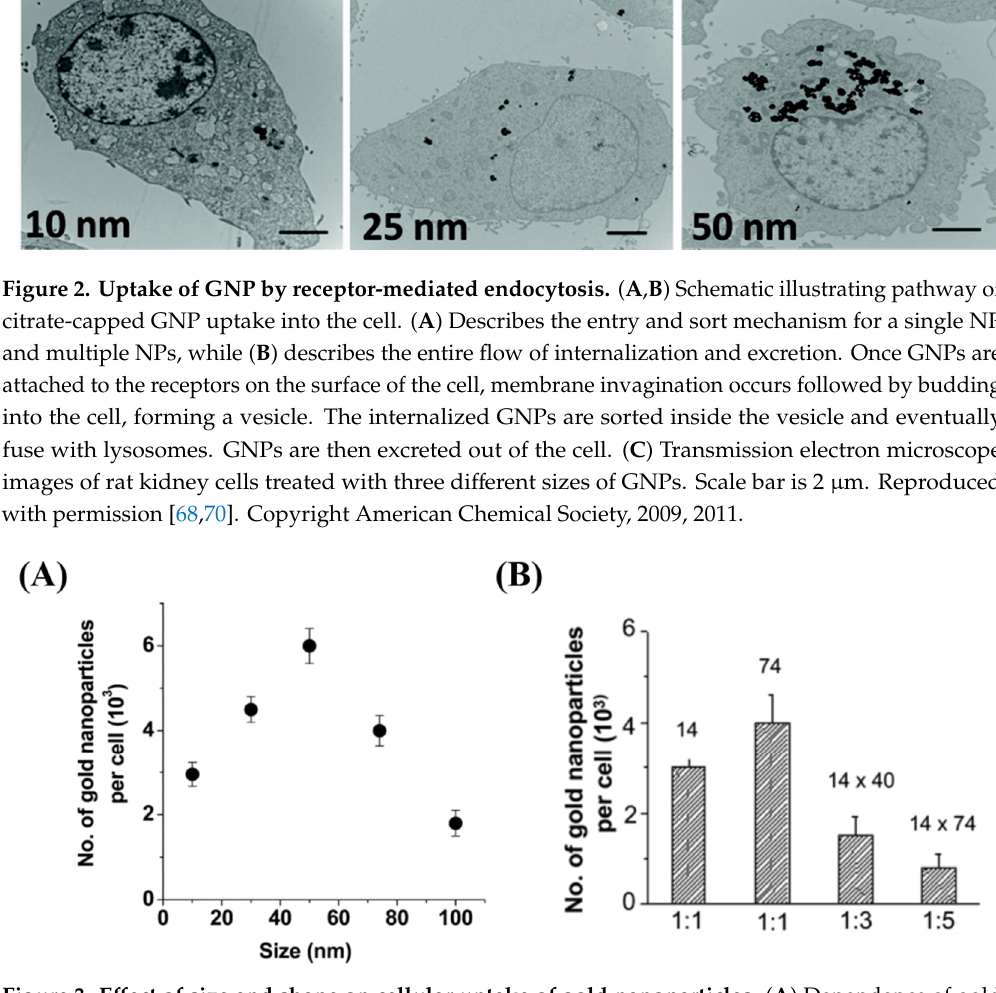
Figure 3. Effect of size and shape on cellular uptake of gold nanoparticles. ( A ) Dependence of gold nanoparticle cellular uptake as a funtion of their diameter. ( B ) Comparison of uptake of rod-shaped nanoparticles (aspect ratios 1:3 and 1:5) and spherical nanoparticles (1:1). Reprinted (adapted) with permission from [66]. Copyright 2006 American Chemical Society.